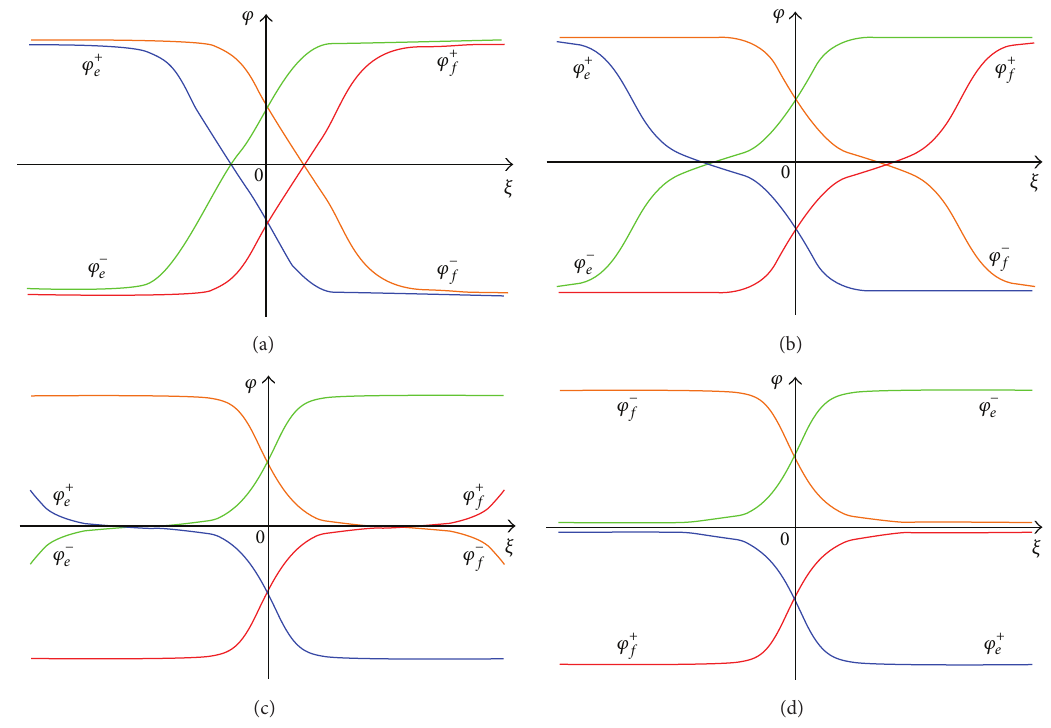
Figure 9: (The four low-kink waves are bifurcated from the four tall-kink waves.) The varying process for the figures of 𝜑 ± 𝑒 and 𝜑 ± 𝑓 when |, (𝑞,𝑝) ∈ 𝐴 𝑝 → 3𝑞 2 /16𝑟−0 , where 𝑟 = 1 , 𝑞 = −4, 𝑙 𝜇 > 0, 𝜇 ̸=|𝜇 0 3 , and (c) 𝑝 = 3 − 10 −4 , and (d) 𝑝 = 3 − 10 −6